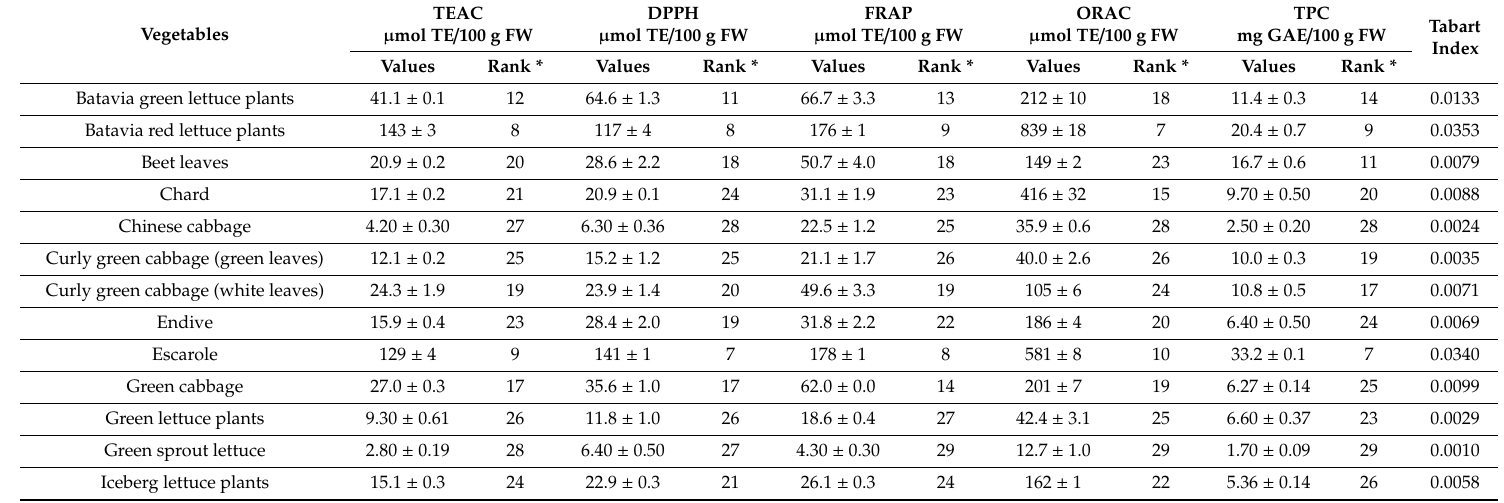
Table 2. Mean values of total antioxidant capacity and total polyphenol content of hydrophilic extracts (HE) by Prior et al. 2003 (14) extraction’s